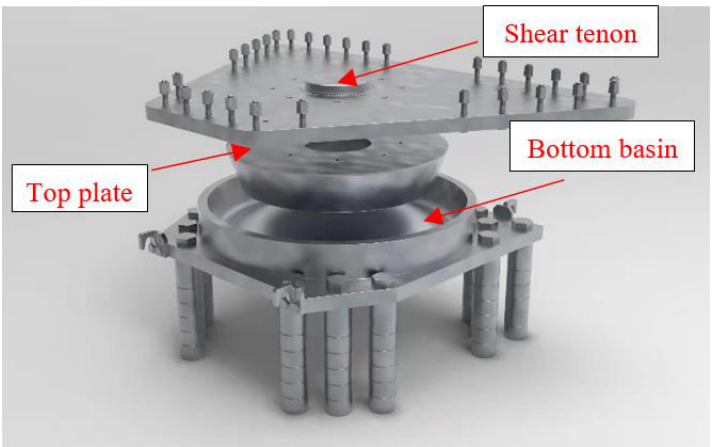
Figure 1. Geometric model of UHS.